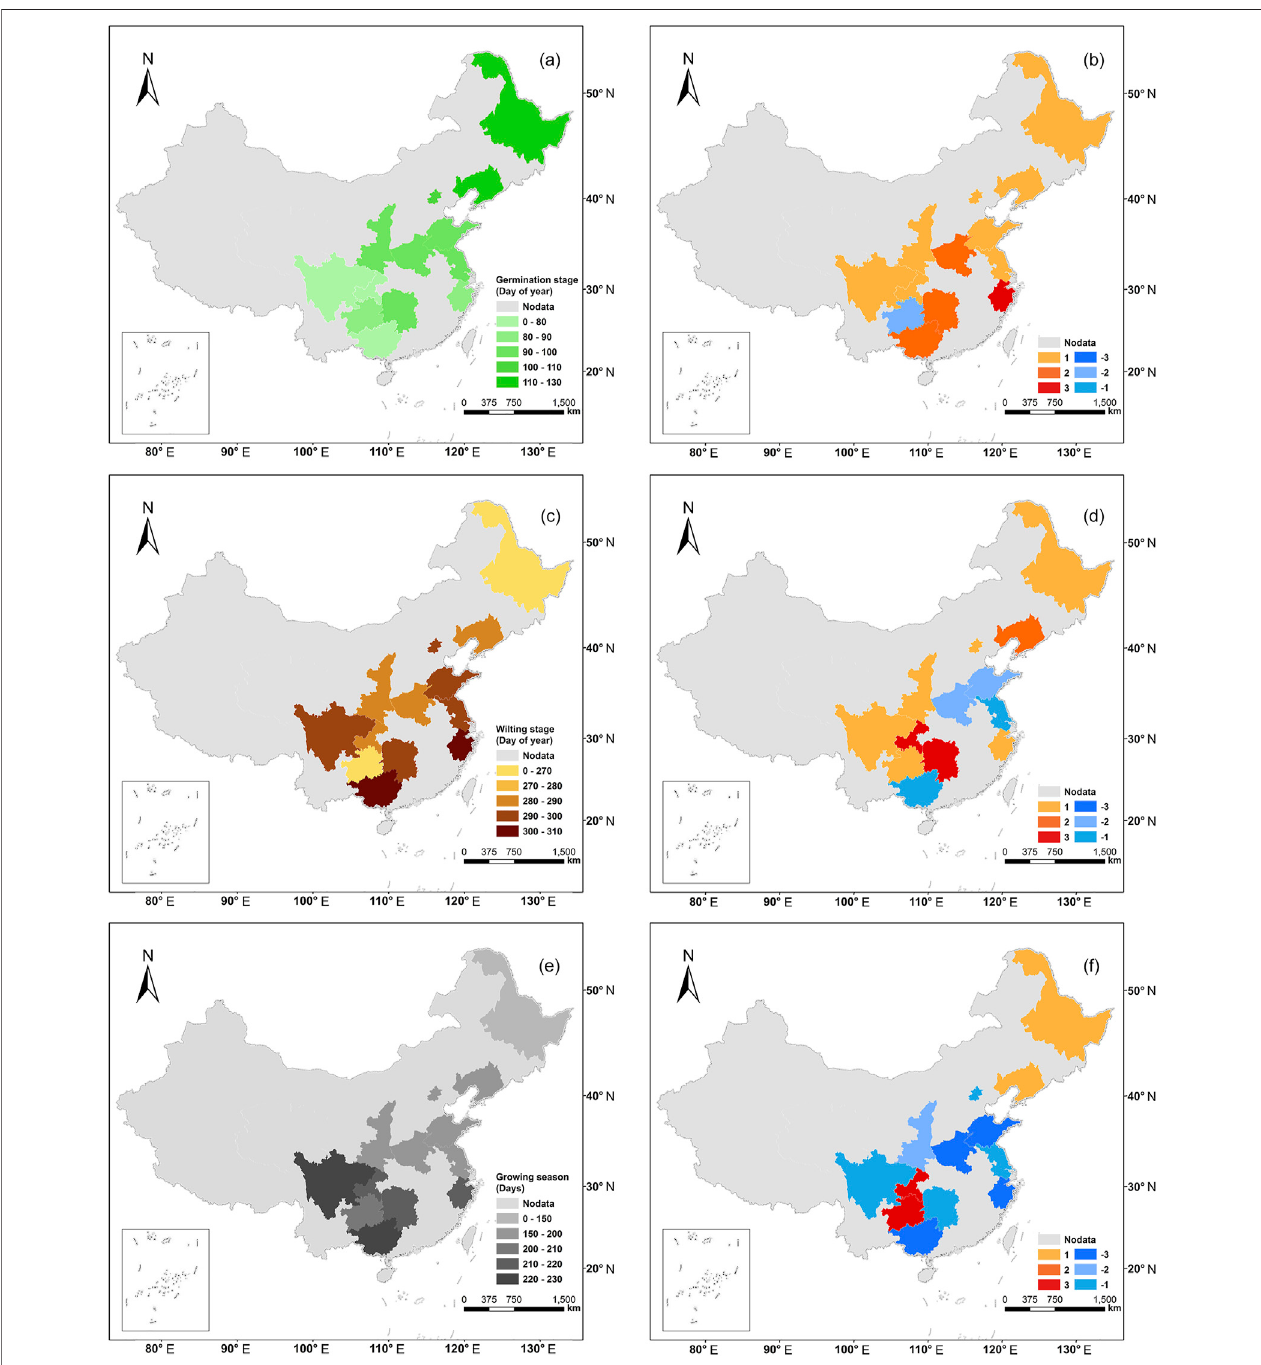
FIGURE 5 | The spatial dynamics of the phenological period at the study sites (1963 – 1988). (A) Spatial distribution of germination stage. (B) Spatial distribution of thechangetrendingerminationstage. (C) Spatialdistributionofthewiltingstage. (D) Spatialdistributionofthechangetrendinthewiltingstage. (E) Spatialdistributionof the growingseason. (F) Spatialdistributionofthe changetrendinthegrowing season. Thelightgrayareas inthe fi gures representtheareas withnodata. In (B) , (D) ,and (F) ,theblue arearepresentsthedecliningtrend,whiletheredarearepresents theincreasingtrend,and thecolorfromlighttodarkindicatesincreasingsigni fi cance ( ± 1: p > 0.05, ± 2: p < 0.05, ± 3: p < 0.01).